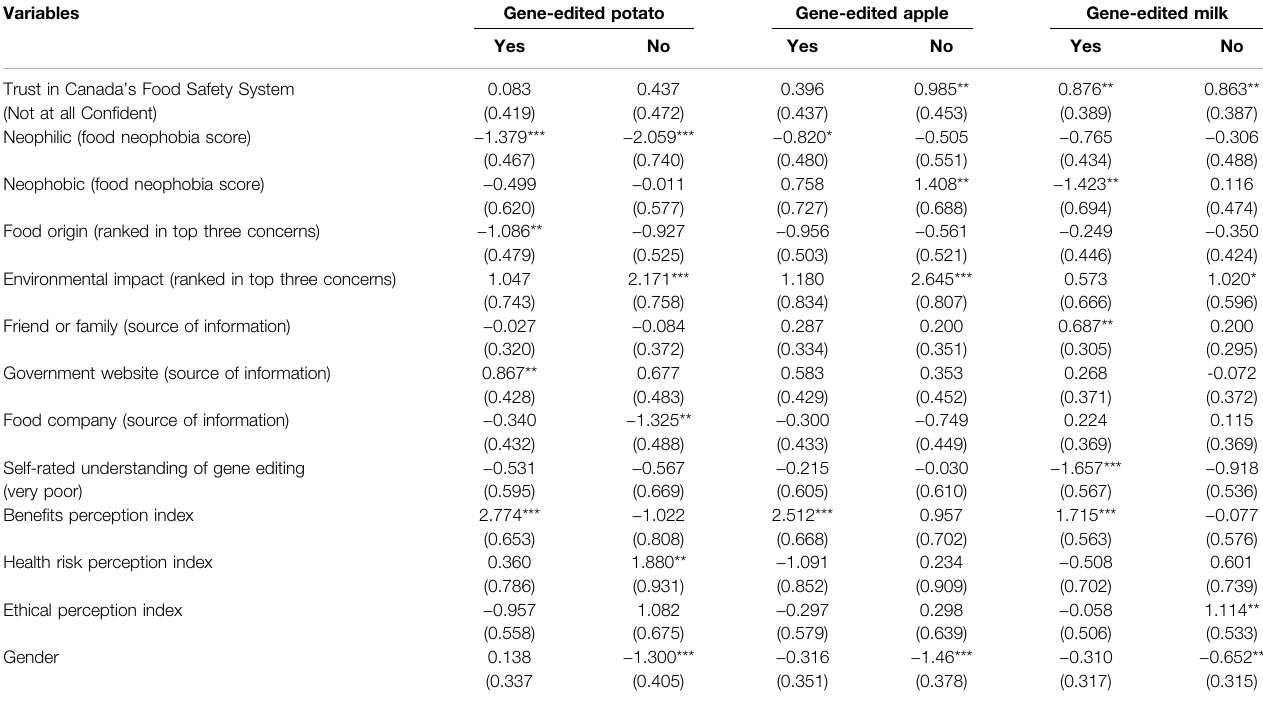
TABLE 5 | Parameters estimated from Multinomial Logit Model.